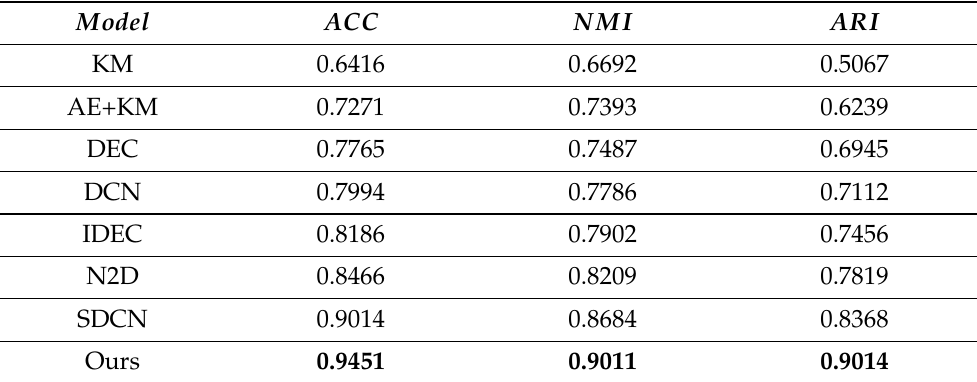
Table 2. Clustering results on different models.